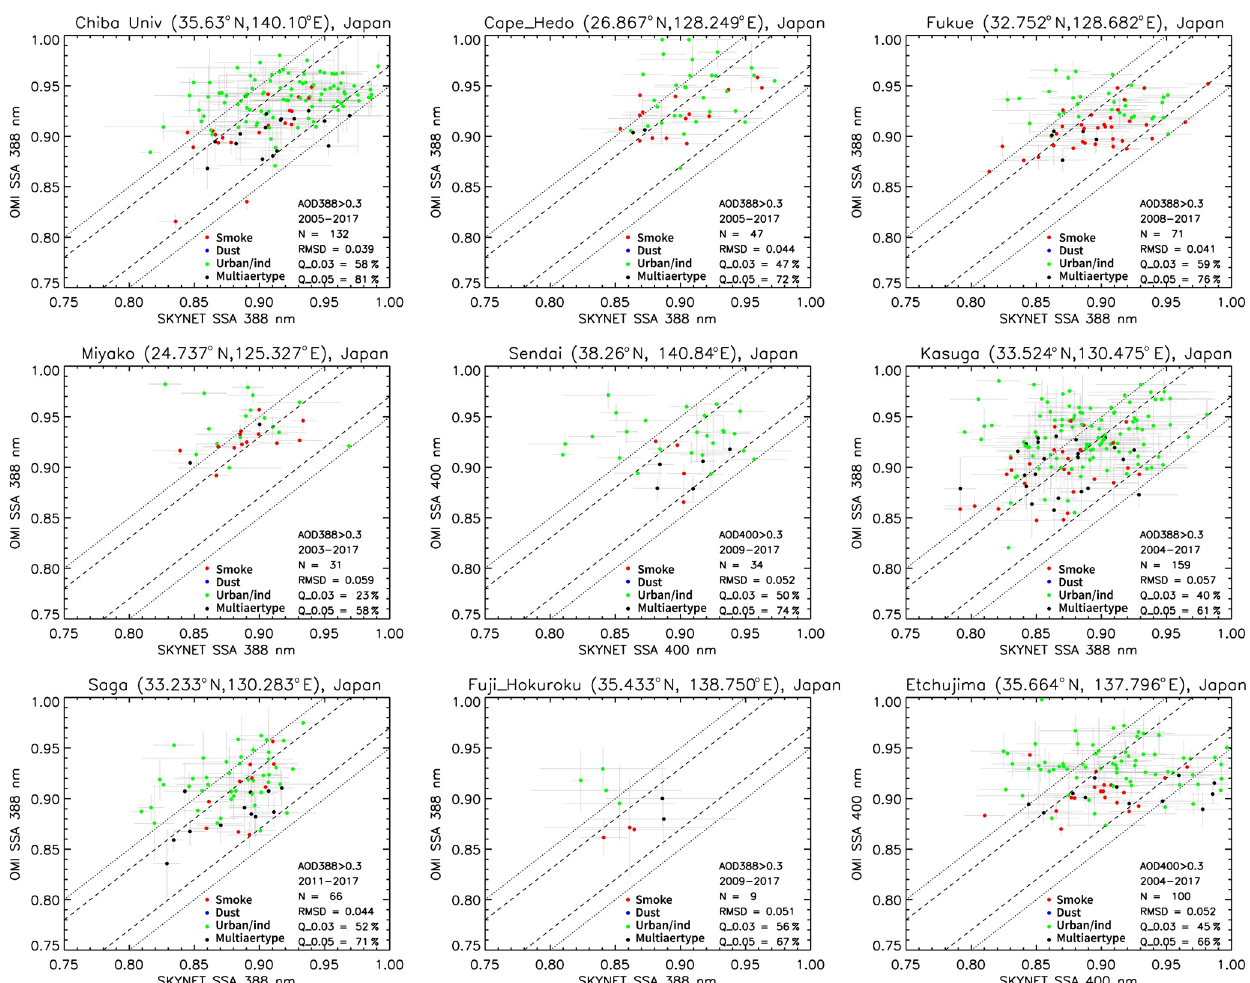
Figure 2. OMAERUV versus SKYNET single-scattering albedo comparison for different sites in Japan. Legends with different colors represent the aerosol type selected by the OMAERUV algorithm for the colocated matchups ( N ). RMSD is the root-mean-square difference between the two retrievals; Q _0.03 and Q _0.05 are the percents of total matchups ( N ) that fall within the absolute difference of 0.03 and 0.05, respectively. OMI–SKYNET matchups with AOD>0.3 (388 or 400nm) in both measurements are used for